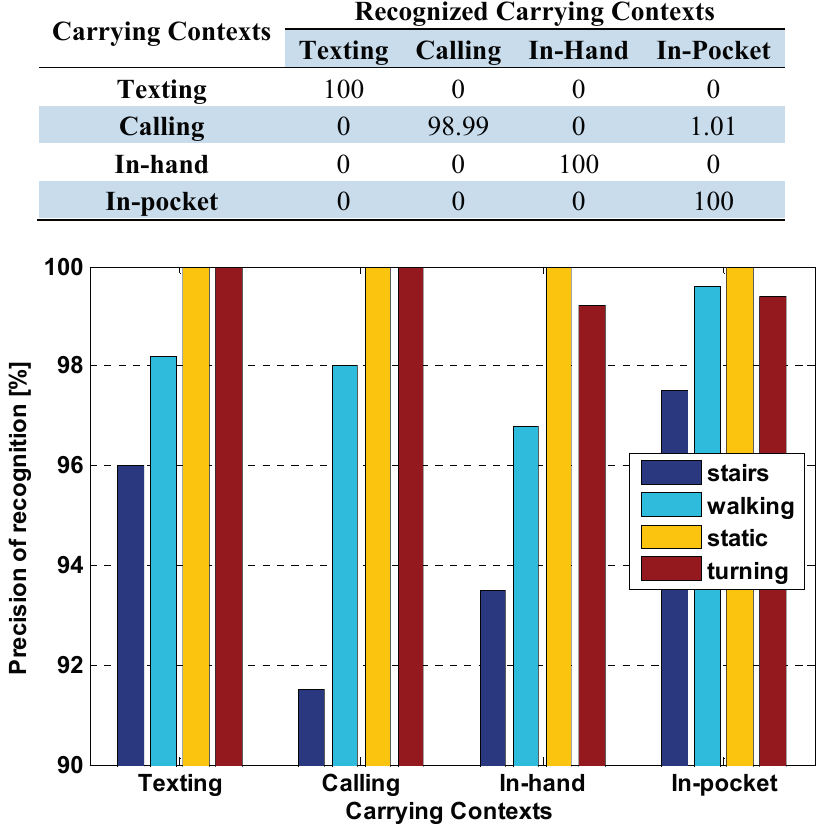
Figure 8. Precision of motions recognition in different contexts of carrying a